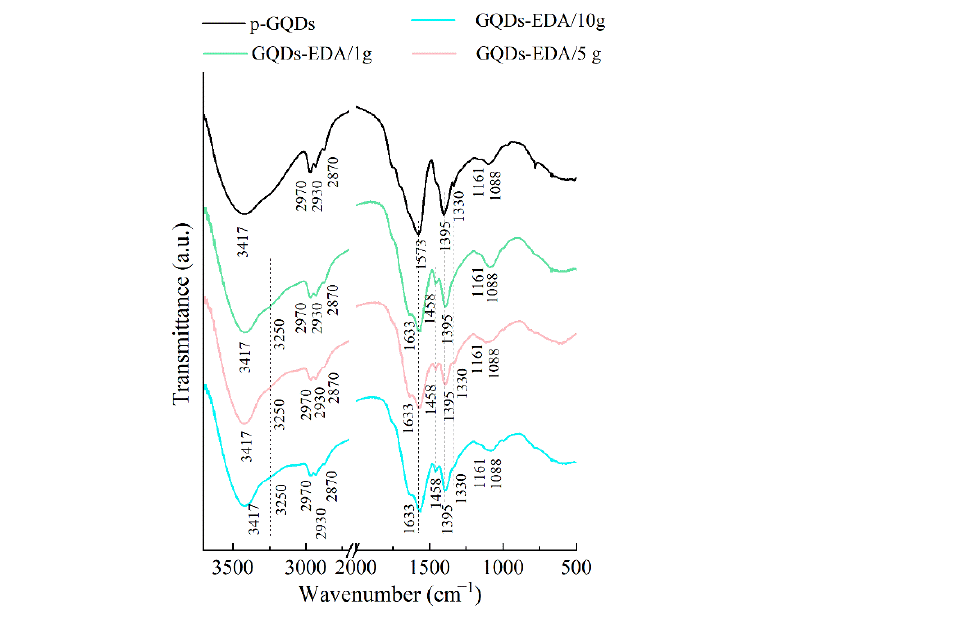
Figure 3. FTIR spectra of p-GQDs, GQDs-EDA/1 g, GQDs-EDA/5 g, GQDs-EDA/10 g.